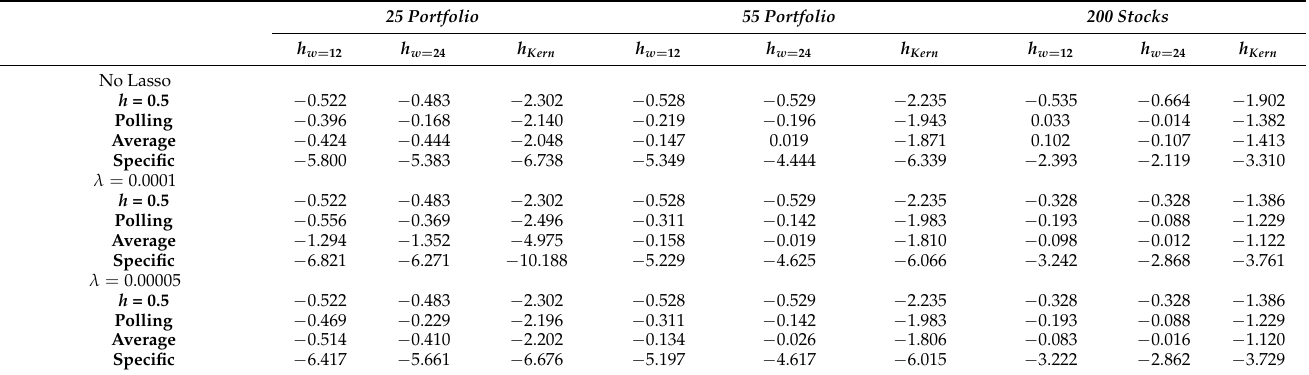
Table A3. Percentage reduction in RMSEs for different penalization parameters in